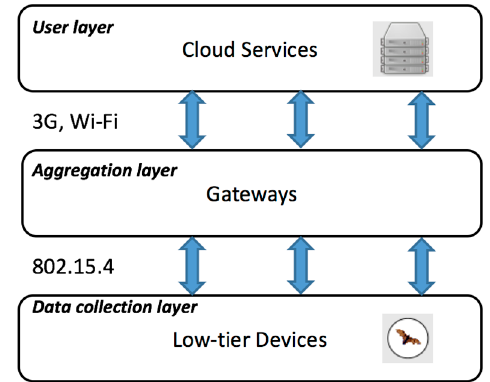
Figure 3. Network architecture of the wildlife tracking framework.